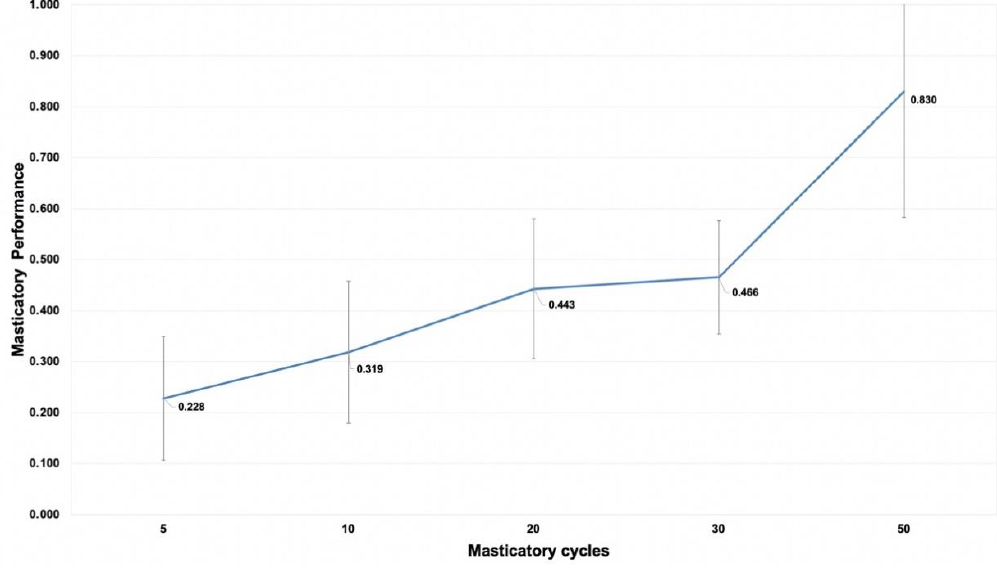
Figure 4. Means and standard deviations of MP in relation to the stepwise increase in the number of masticatory cycles.